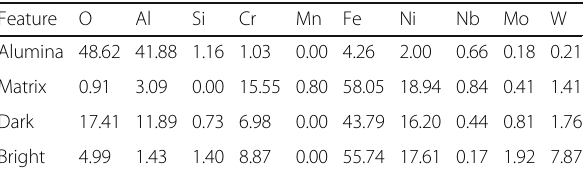
Table 2 Average compositions of the characteristic features in Fig. 3 measured by EDS (at. %) Feature